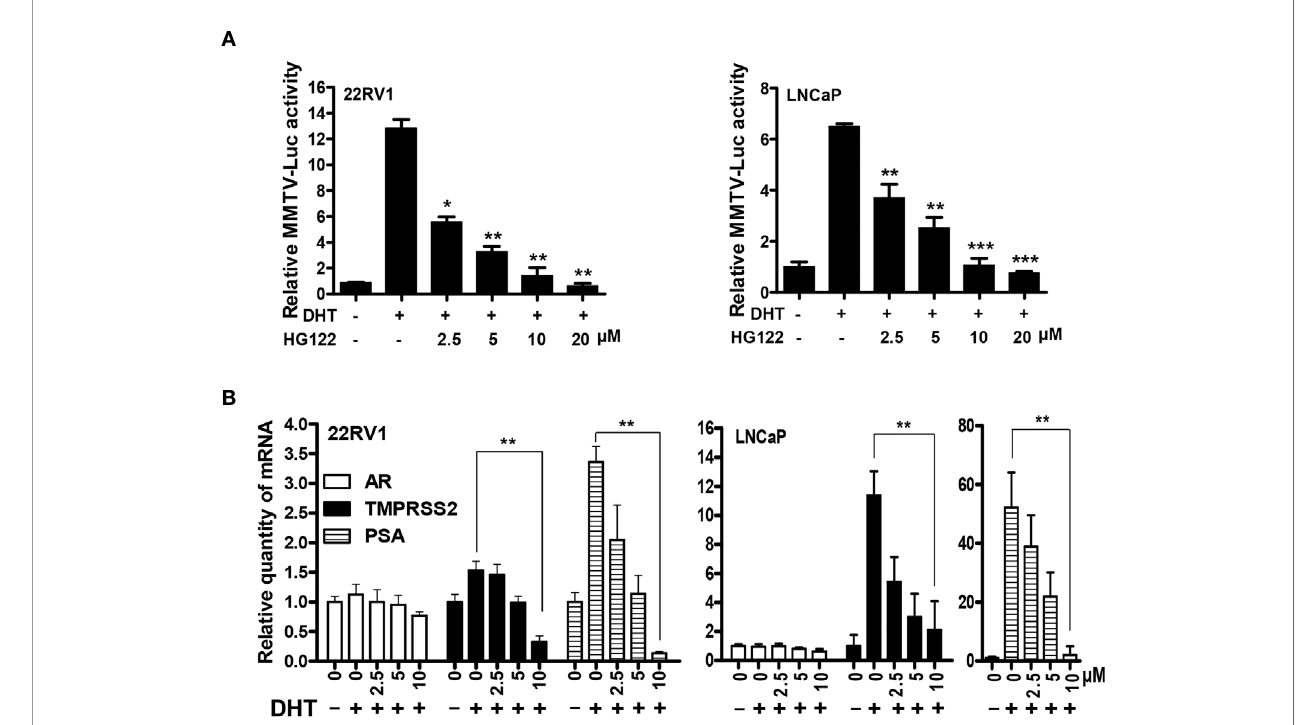
FIGURE 3 | HG122 down-regulated AR target genes. (A) HG122 dose-dependently inhibited DHT-induced AR activity. LNCaP and 22RV1 cells were transiently transfected with MMTV-luc reporter plasmid and Renilla plasmid. Cells were treated with different concentrations of HG122 after stimulated with DHT for 12 h; the luciferase activities were measured, and results were expressed as the ratio of fi re fl y to Renilla luciferase activity (n = 3). (B) HG122 down-regulated the mRNA level of PSA and TMPRSS2, but not that of AR. The mRNA levels of PSA, TMPRSS2, and AR were measured using quantitative-PCR and normalized to GAPDH. *, P < 0.05; **, P < 0.05; ***, P <